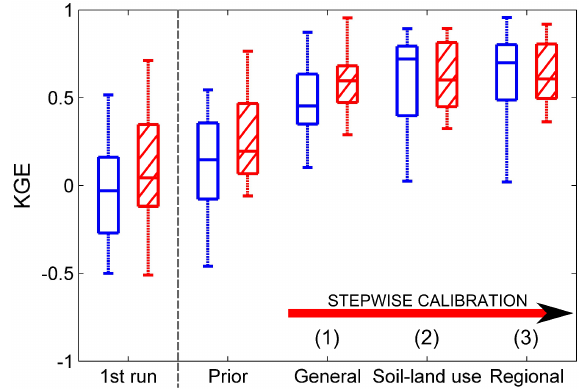
Figure 9. Improvements in model performance (average KGE for 30 stations) during the stepwise calibration approach (steps 1–3 cor- respond to general, soil-land use, and regional calibration as de- scribed in Sect. 3.3). “1st run” corresponds to model performance of the very first model set-up to establish a technical model infras- tructure. “Prior” corresponds to model performance before param- eter calibration and after overcoming routing errors. The evaluation is conducted at the calibration (blue) and the validation (red shaded)